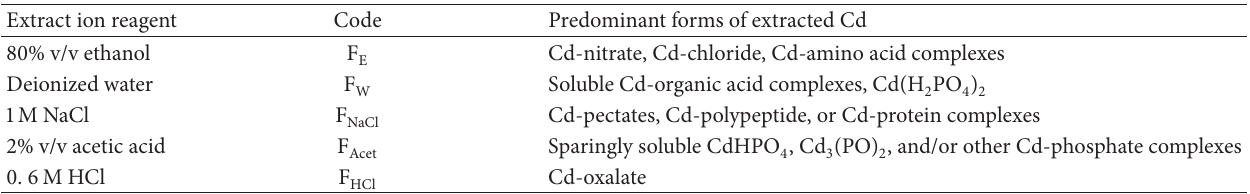
Table 1: Extractants and relevant extracted chemical forms of